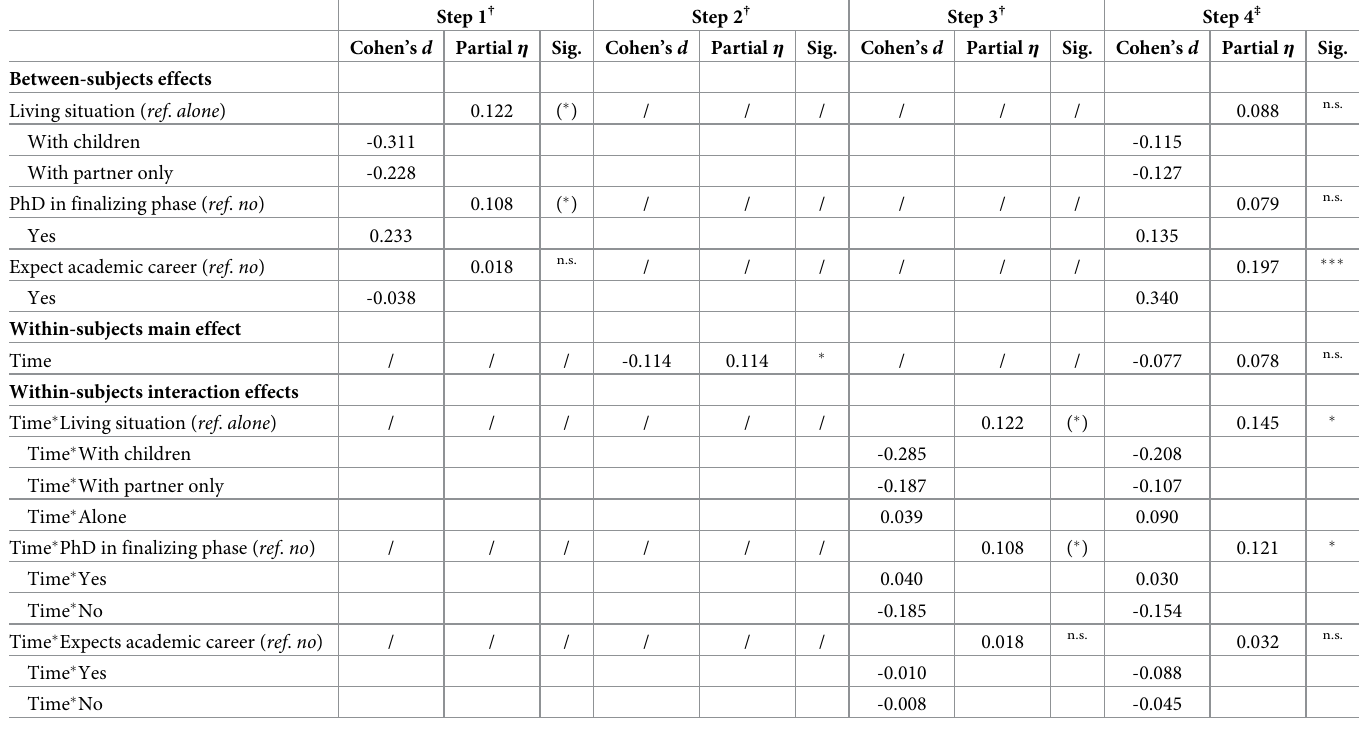
Table 4. Results of one-way repeated measure ANOVA for composite measure of satisfaction with supervisor support for cohort